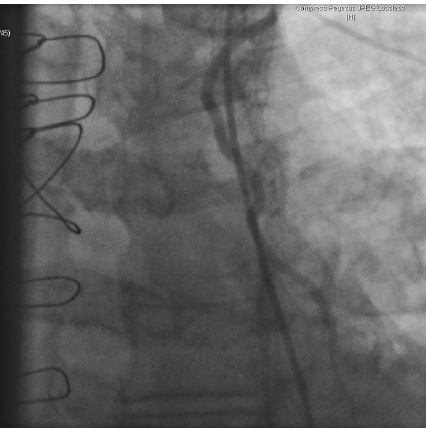
Figure 5: Interpretation: Patent LIMA graft to